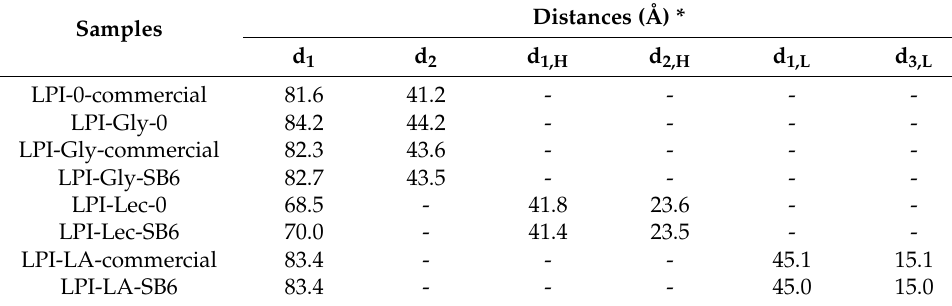
Figure 3. I × q 2 vs. q Small Angle X-ray Scattering (SAXS) profiles of lupin foams. ( a ): effect of TGs and glycerol, ( b ): effect of TG (SB6) and lecithin and ( c ): effect of TGs and linoleic acid. Curves were vertically shifted for better visualisation. Table 1. Characteristic distances, d-values in Å, observed by SAXS .